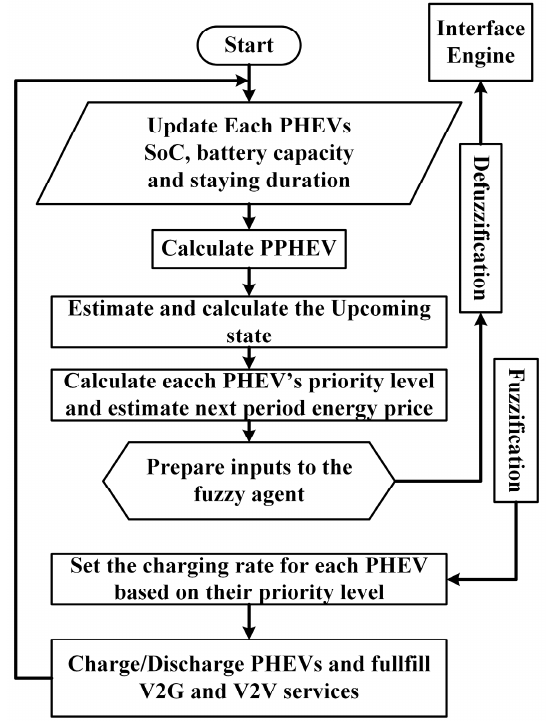
Figure 74. Flowchart of the management system proposed by Mohamed et al. [187].